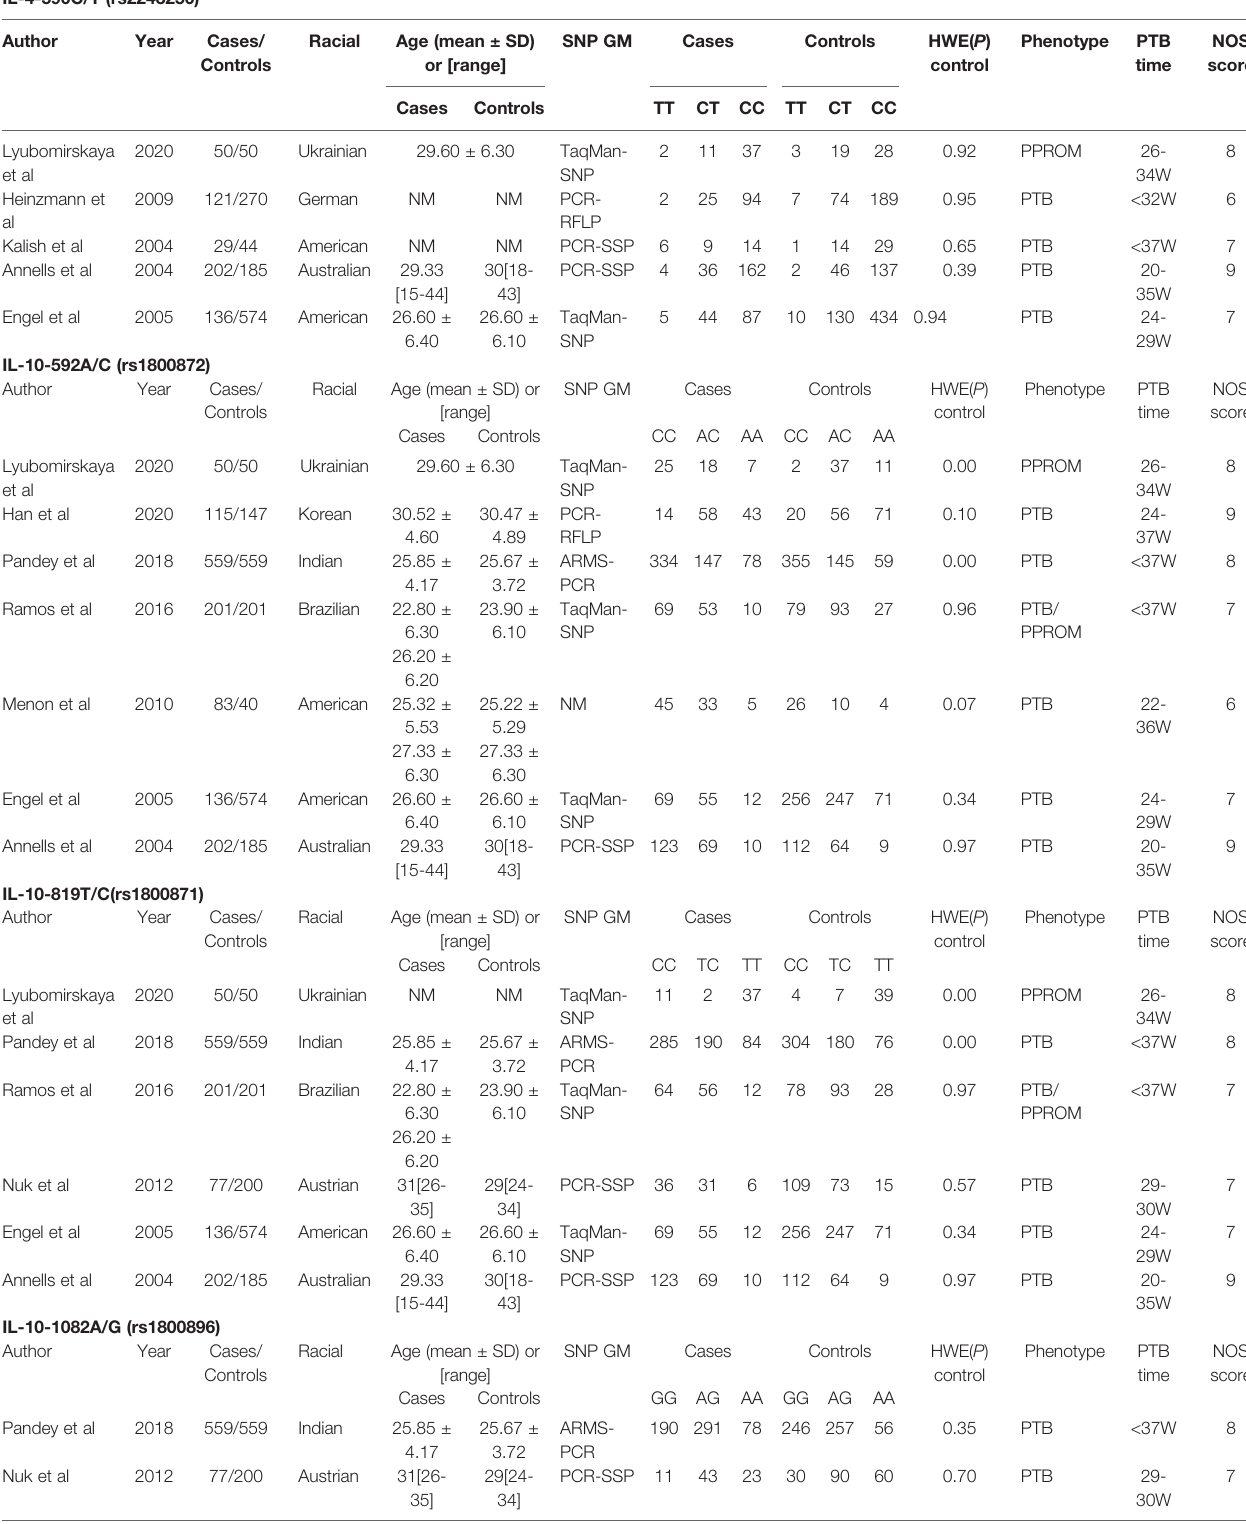
TABLE 1 | Main characteristics of included